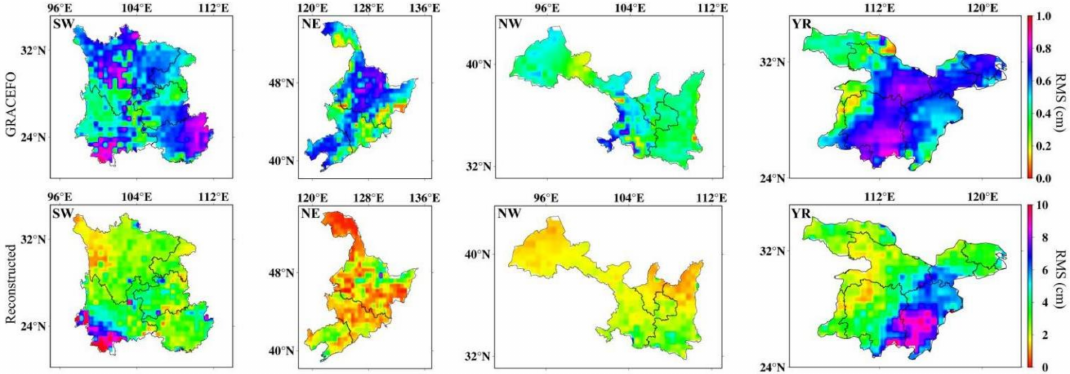
Figure A2. RMS plots of GRACE-FO-based TWSC and reconstructed TWSC in the four study regions from June 2018 to July